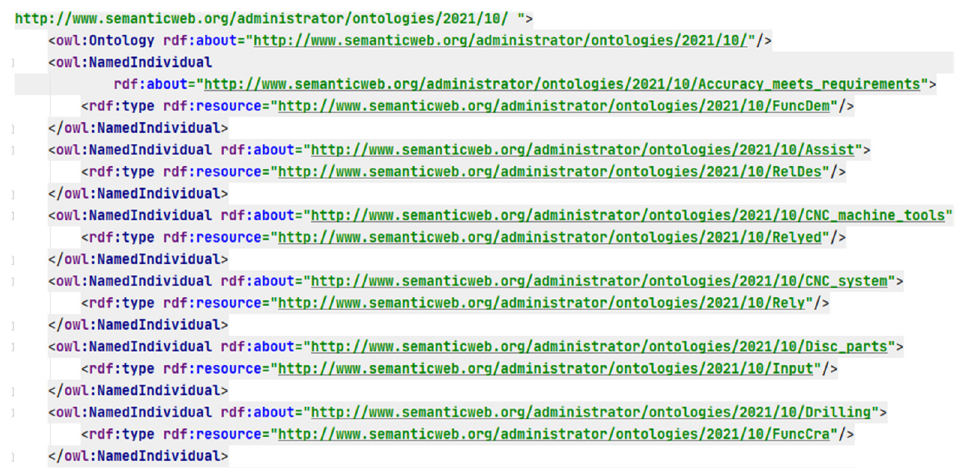
Figure 3. The ontological diagram of the descriptive model.